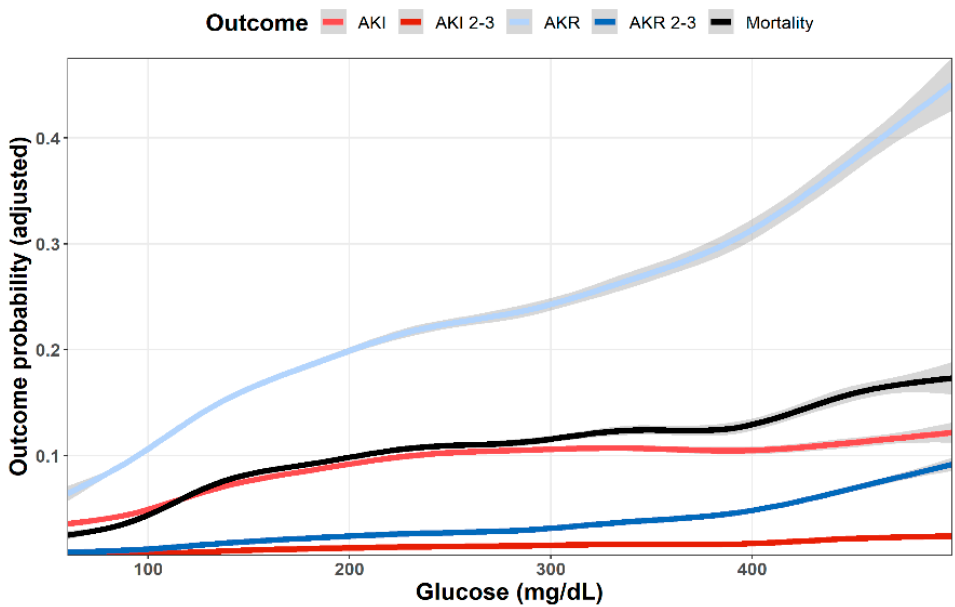
Figure 1. Predicted probability of various outcomes (AKI, AKI stages 2–3, AKR, AKR stages 2–3, dialysis and mortality at 30 days) as a function of baseline glucose levels. Lowest and highest 0.5% percentile of patients by glucose levels were excluded. Data were plotted using cubic splines.